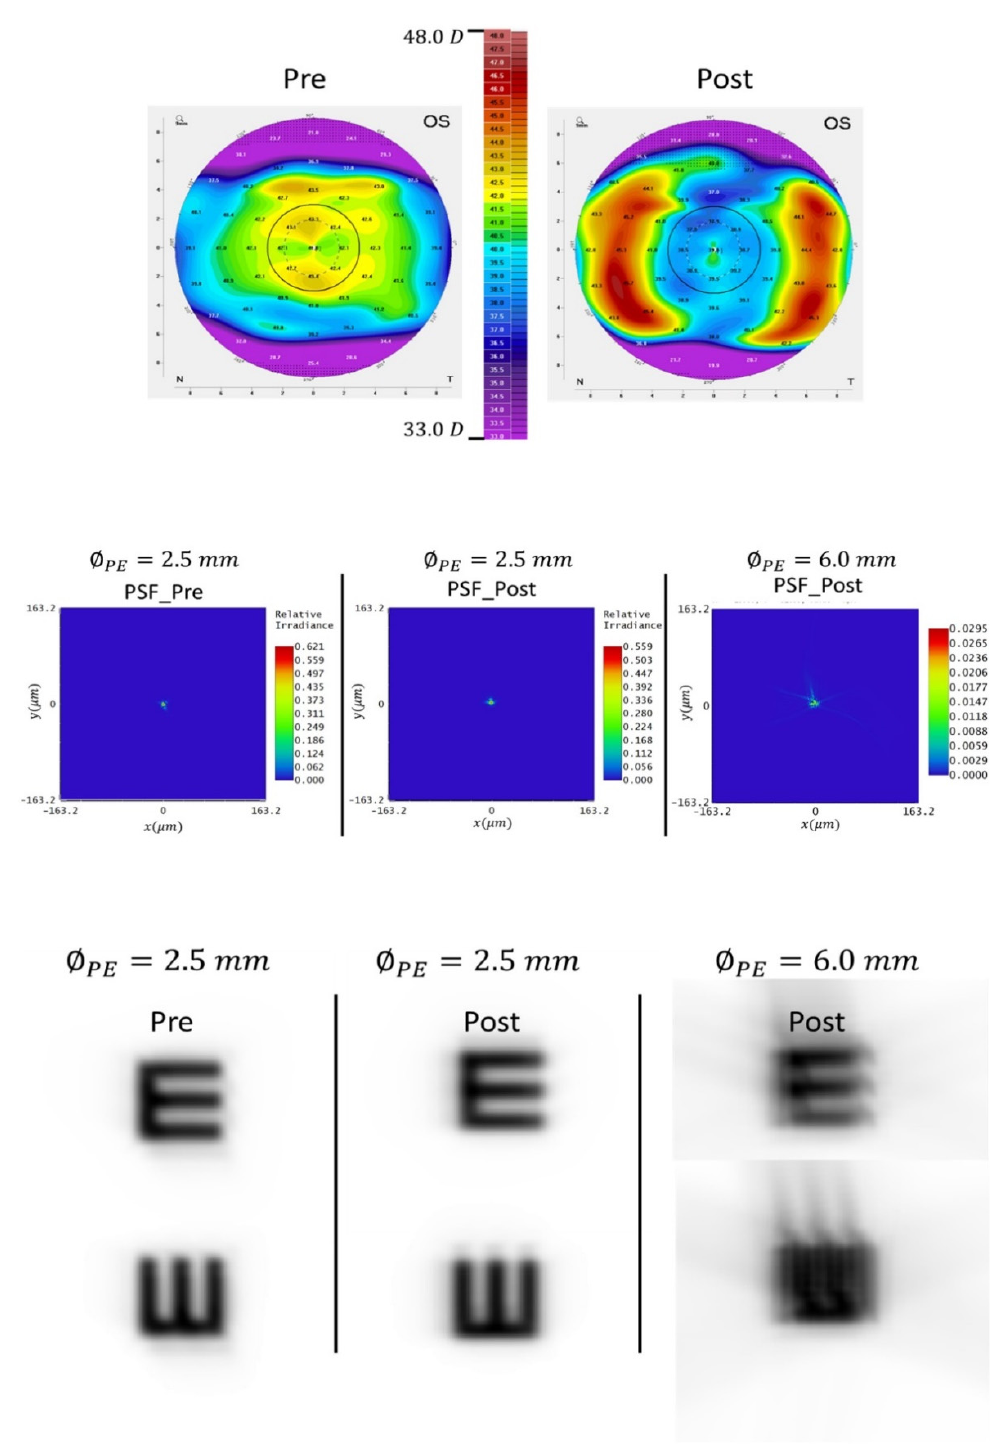
Figure 4. For Eye1, ( up ) pre- and postoperative topographies. Pupil size of 2.5 mm centred in apex is indicated with black circle; ( middle ) pre- and postoperative PSF functions for 2.5 mm and 6 mm pupil sizes; ( down ) pre- and postoperative vision simulated optotype for 2.5 mm and 6 mm pupil sizes.